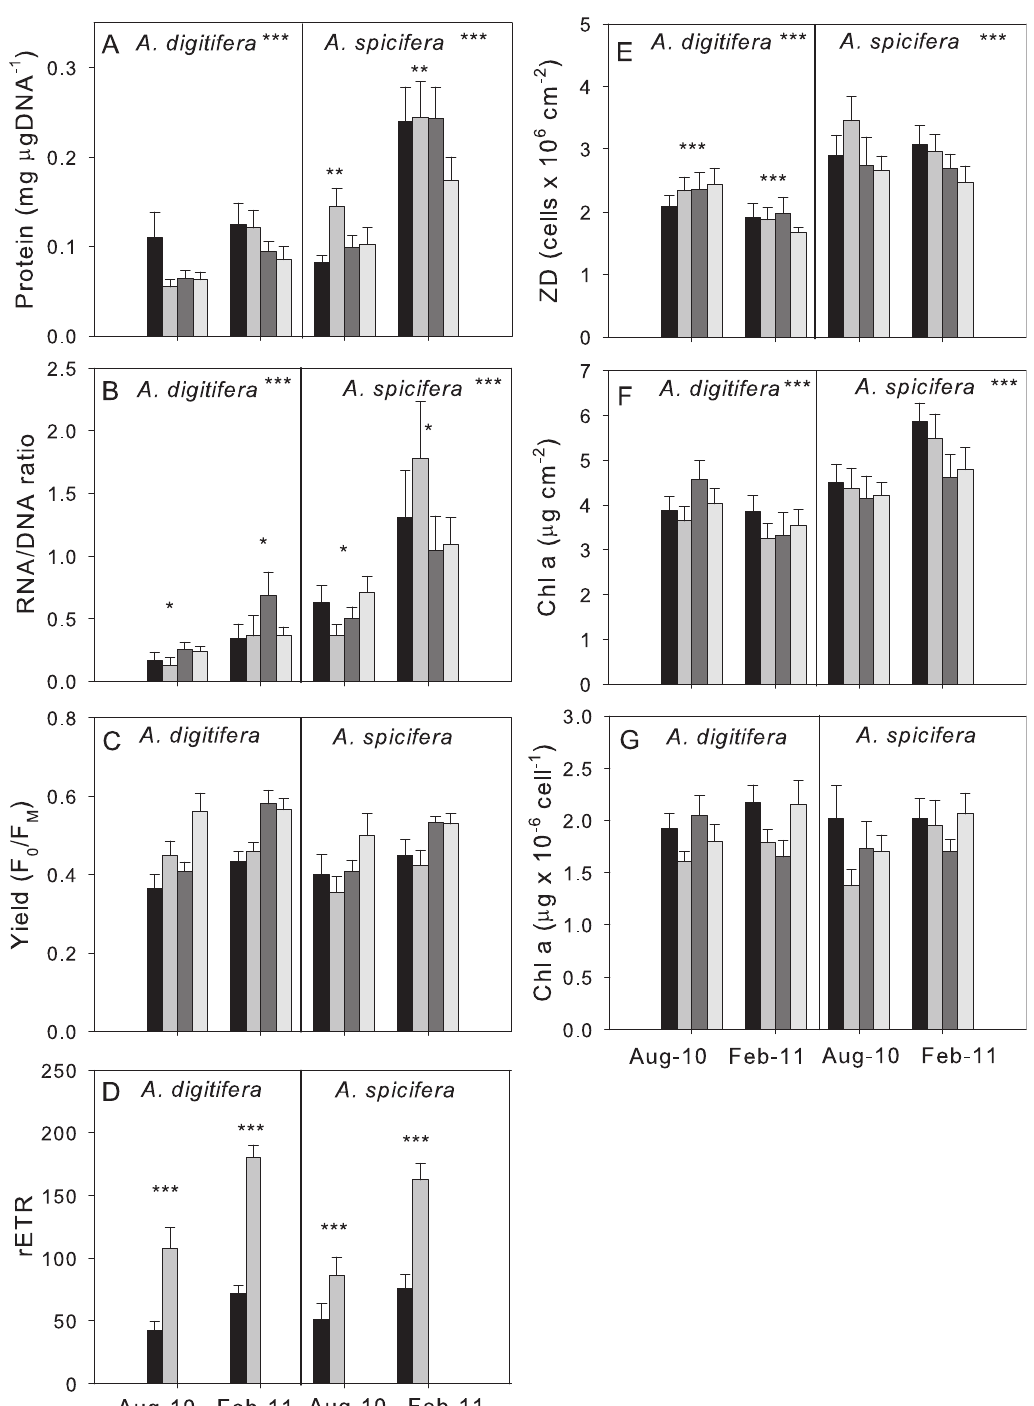
Figure 2. Diel pattern for health indices for Acroporadigifera and Acoropraspicifera at Ningaloo Reef. Values represent Means 6 Standard Error (SE), n=9–12 for metabolic indices (protein concentration, RNA/DNA ratio) and autotrophic indices (zooxanthellae density, Chlorophyll a concentration (per surface area and per cell), yield and rETR)) at four different times per day in August 2010 and February 2011. Black bar=morning (6–7 am), mid grey bar=noon (12–1 pm), dark grey bar=evening (6–7 pm), light grey bar=midnight (12–1 am). Stars symbolize significant differences between species (next to coral names) and seasons (above bars) (*P , 0.05; **P , 0.01; ***P , 0.001). doi:10.1371/journal.pone.0063693.g002 for protein concentration revealed that only A. spicifera showed significant differences were only found for A. digitifera (p , 0.001) seasonal differences (p , 0.01) with higher protein concentrations based on higher values during winter (Fig. 1) compared with in summer than in winter, while for zooxanthellae density summer. RNA/DNA ratios showed seasonal differences for both